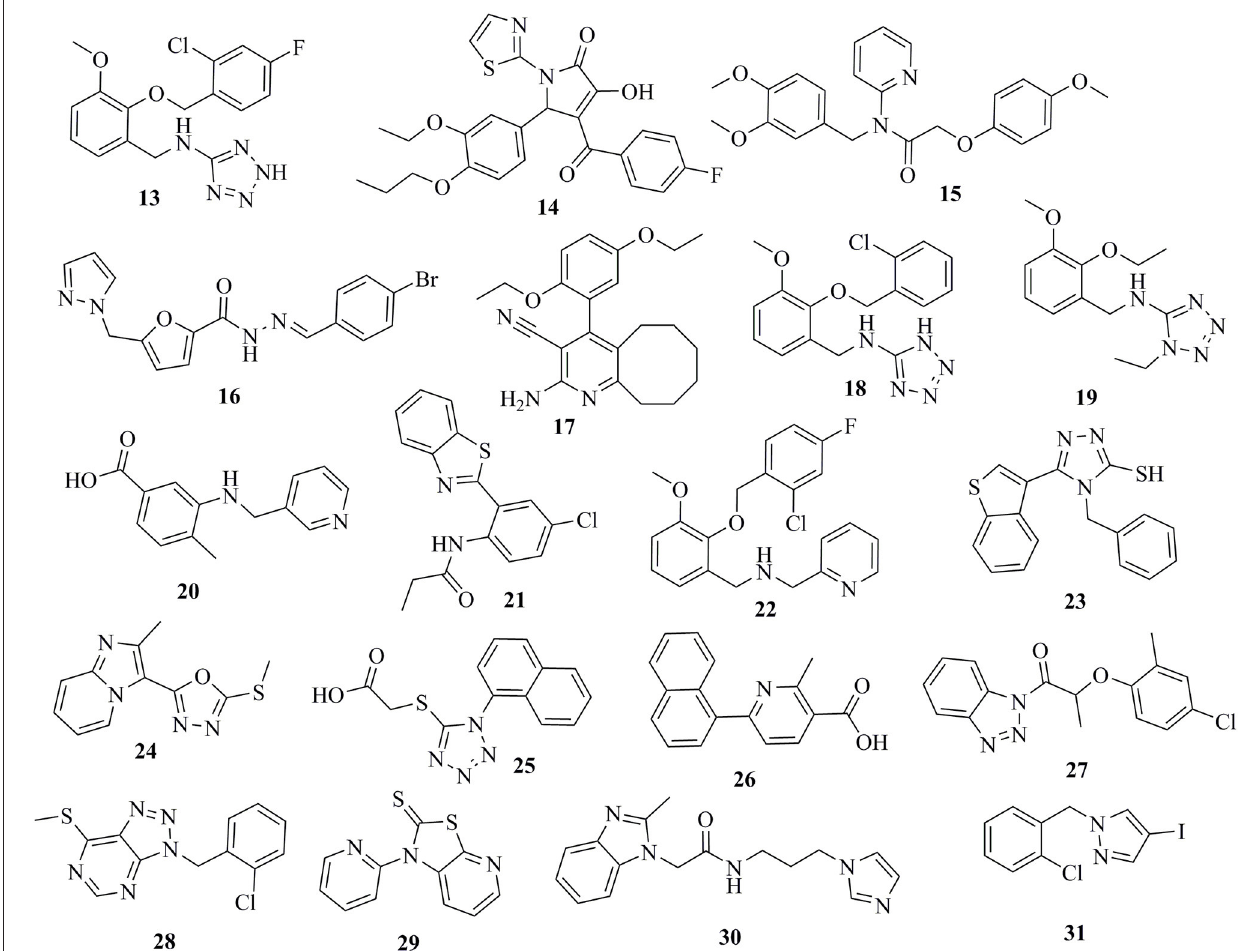
FIGURE 6 | Inactive compounds 13–31 tested against CYP11B1 and CYP11B2.